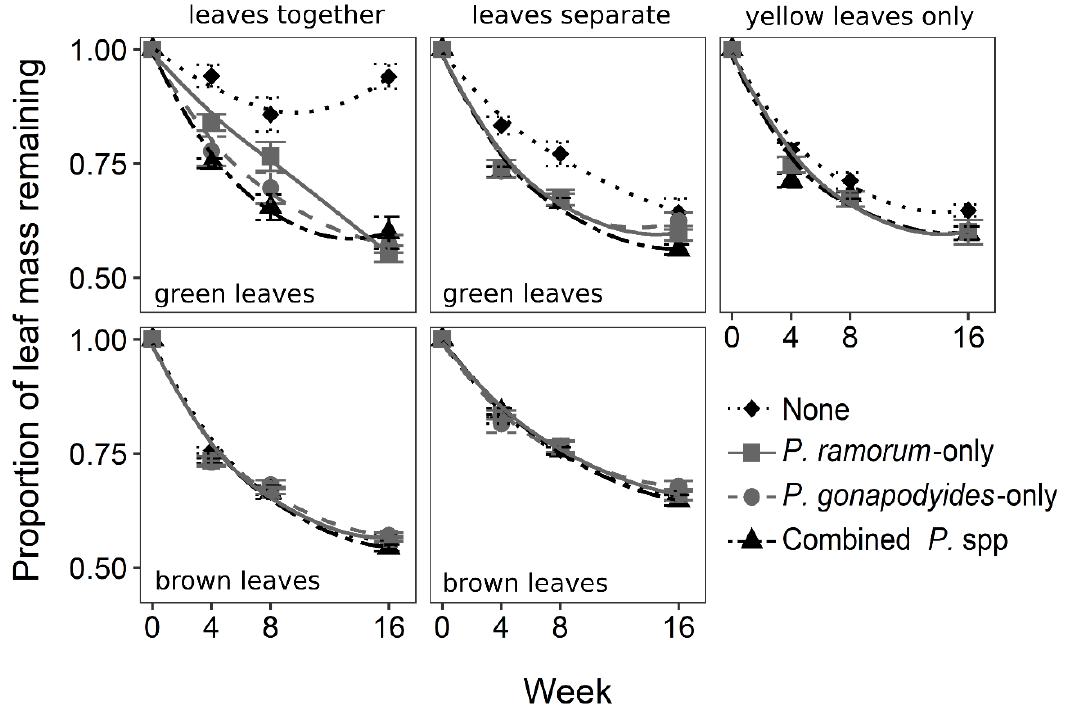
Figure 2. Leaf decomposition represented as a proportion of leaf mass remaining at sampling intervals over 16 weeks for green (top left two panels), brown (bottom panels) and yellow leaves exposed to three Phytophthora inoculum treatments and one non-inoculated control in three different experiments (vertical panels). Two experiments included green and brown leaves, the first with both leaf types together in the same microcosm and the second with each leaf type separate in different microcosms. One experiment included yellow leaves only with only P. ramorum and combined Phytophthora species inoculum treatments. Results are averaged over stream water treatments which did not have a significant e ff ect, except for the experiment with yellow leaves which used only sterile nutrient solution. Bars represent ± standard error, n =